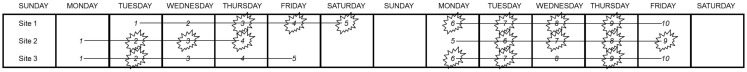
Representation of training schedule and days of blast exposure across a 2-week period for each of the three study sites. Training days are labeled with serial Session numbers, with Sites 1 and 3 showing 10 Sessions and Site 2 showing 9 Sessions. Sessions with blast exposure are indicated by a jagged line surrounding the Session serial number. Group-level blast was recorded in 7 of 10 Sessions at Site 1, 7 of 9 Sessions at Site 2, and 4 of 10 Sessions at Site 3.